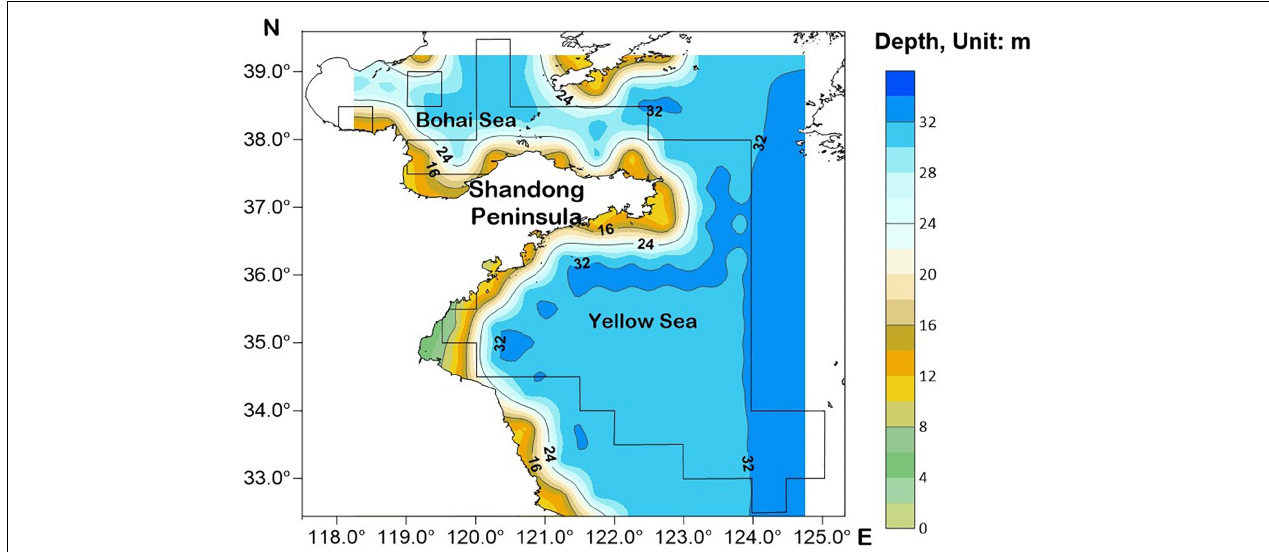
FIGURE 1 | Scope of the Shandong coastal waters and fishing areas where Lophius litulon occur.